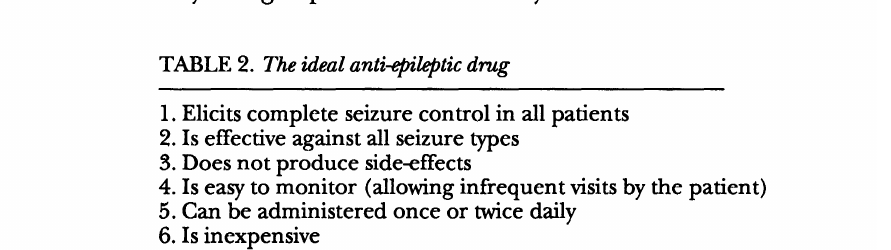
TABLE 2. The ideal anti-epileptic